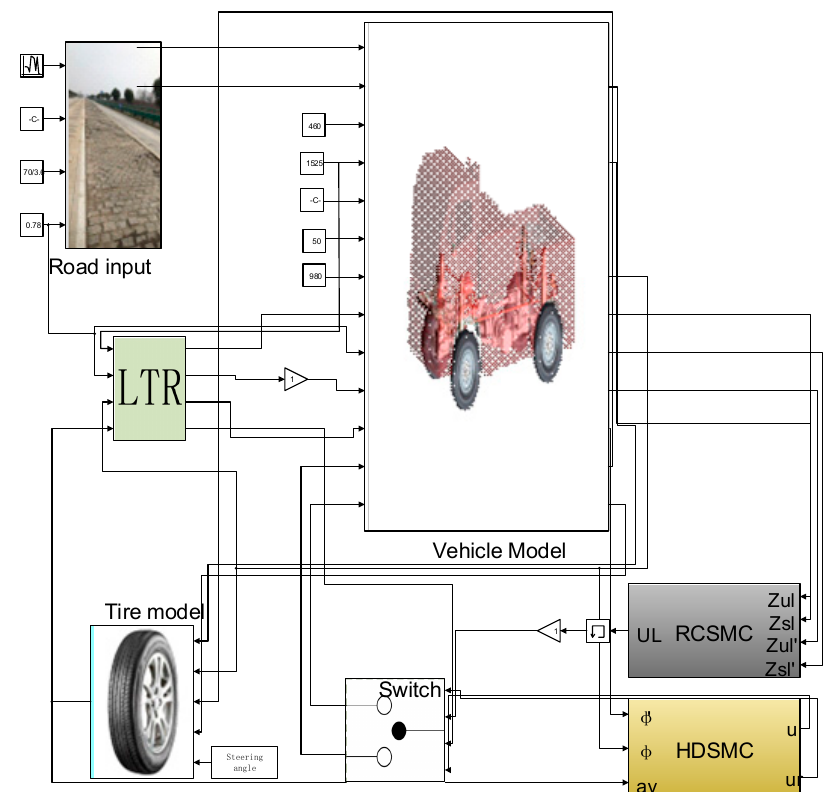
Figure 10. Vehicle model in MATLAB/Simulink.